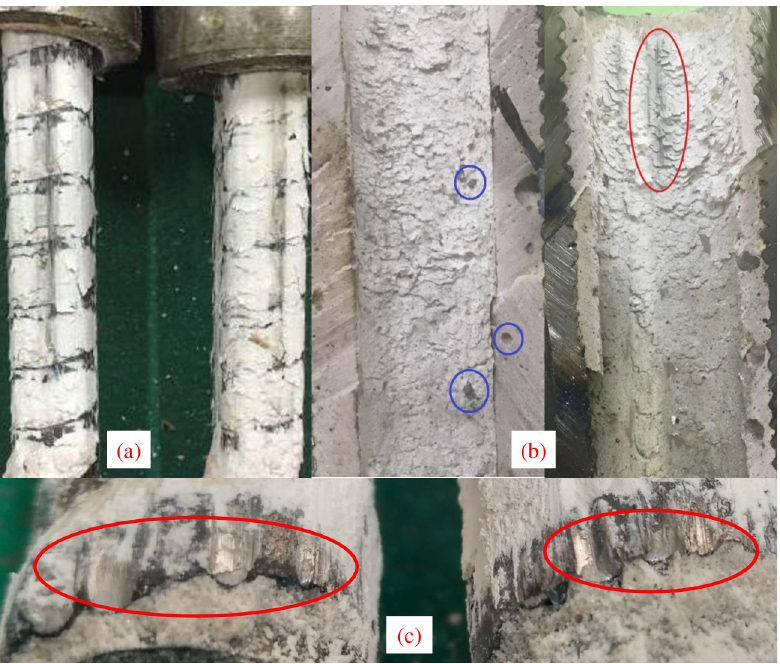
Fig 24. Failure surface observation (a) The scratches caused by the aggregates on the failure interface. (b) The scratch in the red circle is caused by aggregates, however, the aggregates in the blue circles do not produce a doweling effect. (c) The damage to the bolt ribs because of the doweling